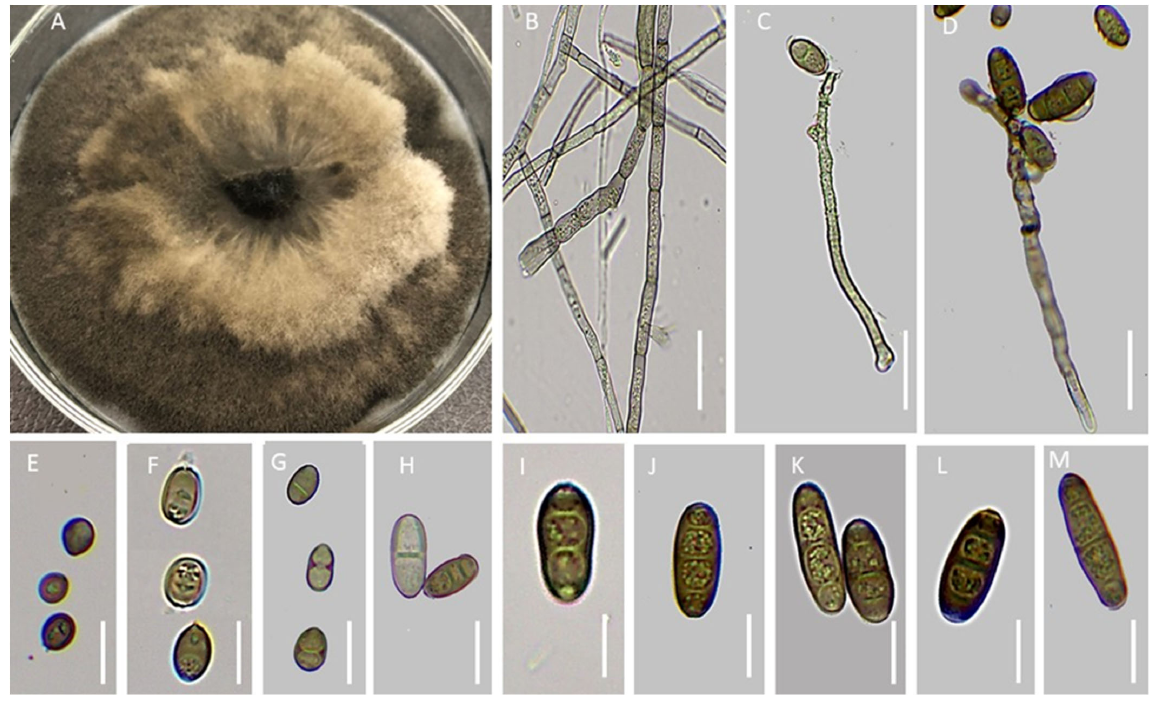
Figure 3. Morphological features of Curvularia hawaiiensis . ( A ). Colony on PDA; ( B ). Mycelium; ( C , D ). Conidiophore and conidia; ( E – M ). Conidia. Scale bar: ( B – D ) = 30 μ m; ( E , F ) = 15 μ m; ( G – M ) = 20 μ m.